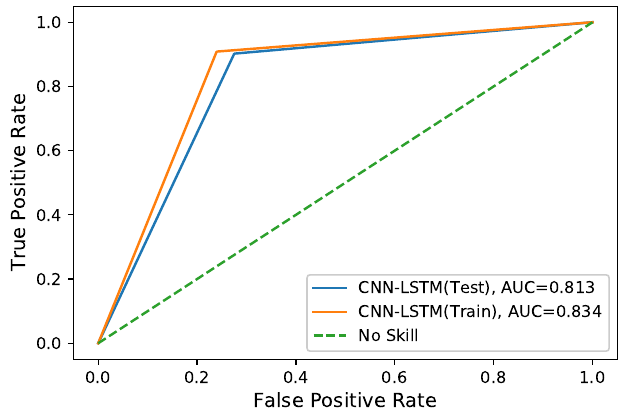
Figure 11. ROC-AUC of CNN–LSTM